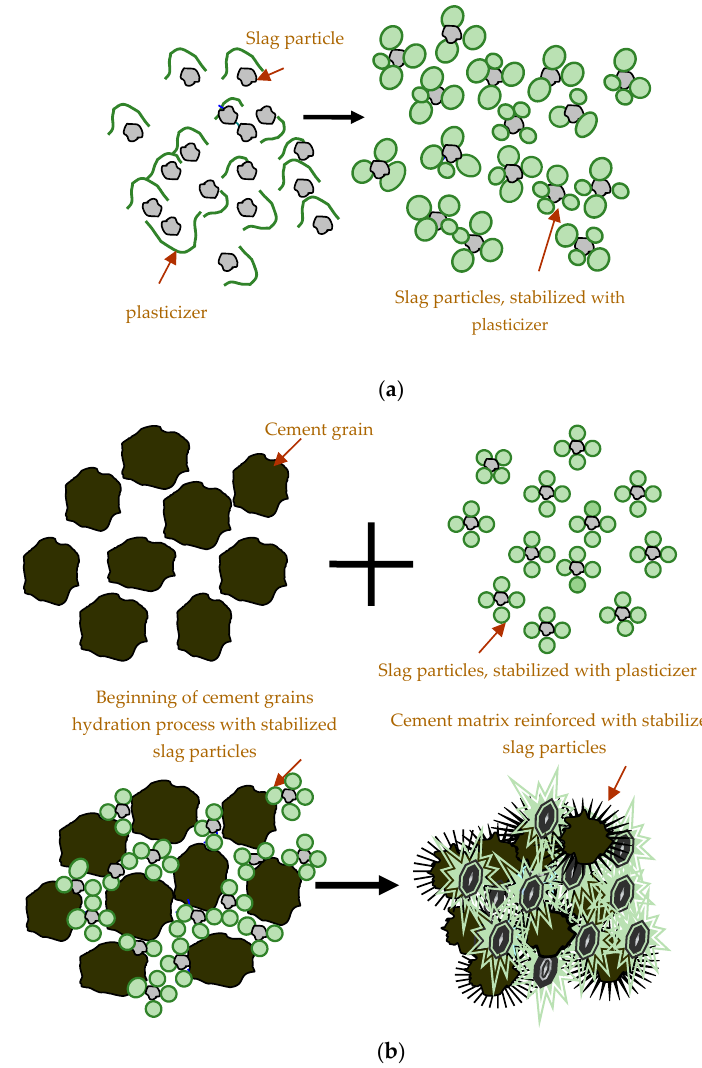
formed as a product of hydrolysis and hydration of clinker minerals, which promotes intensive nucleation and growth of crystallohydrates. Figure 24. A schematic representation of GGBS particles stabilization with a plasticizer ( a ) and the participation of slag stabilized with a plasticizer in the construction of a cement stone matrix ( b ). Stabilized slag particles not only act as centers of directed crystallization, concen- trating hydration products on their surface, but also react with calcium hydroxide